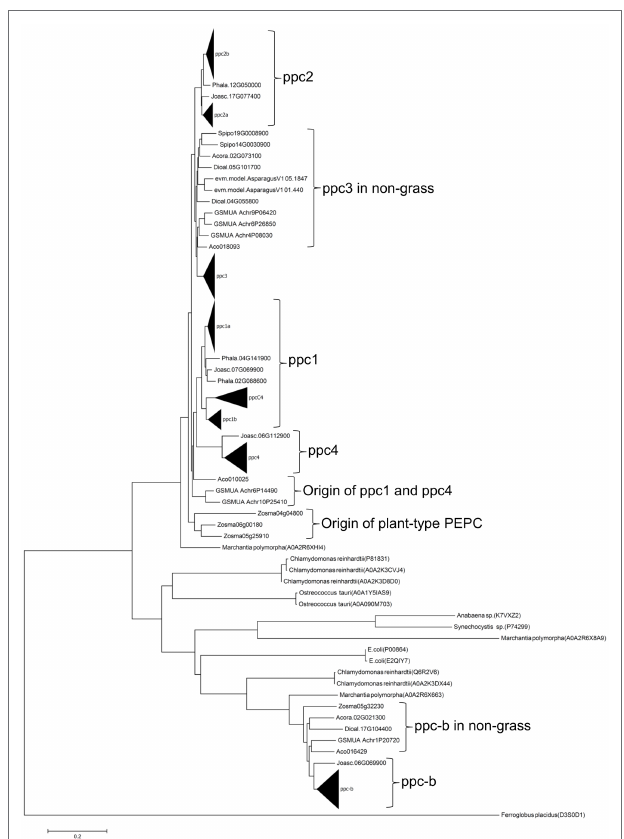
FIGURE 6 | A NJ phylogenetic tree with JTT model for monocot PEPCs. Key PEPC protein identifiers are follows: Joasc.17G077400, Joasc.09G001100, Joasc.06G112900, and Joasc.07G069900 ( Joinvillea ascendens ), Phala.12G050000, Phala.04G0141900, and Phala.02G088600 ( Pharus latifolius ), Spipo19G0008900 and Spipo14G0030900 ( Spirodela polyrhiza ), Acora.02G073100 and Acora.02G021300 ( Acorus americanus ), Aco018093, Aco010025, and Aco016429 ( Ananas comosus ), Dioal.05G101700, Dioal.04G055800, and Dioal.17G104400 ( Dioscorea alata ), evm.model.AsparagusV1 05.1847 and evm.model.AsparagusV1 01.440 ( Asparagus officinalis ), GSMUA Achr9P06420, GSMUA Achr6P26850, GSMUA Achr4P08030, GSMUA Achr6P14490, GSMUA Achr10P25410, and GSMUA Achr1P20720 ( Musa acuminata ), Zosma04g04800, Zosma06g00180, Zosma05g25910, and Zosma05g32230 ( Zostera marina ). Black triangles represent sub-lineages of PEPC types. The bar shows the branch length of